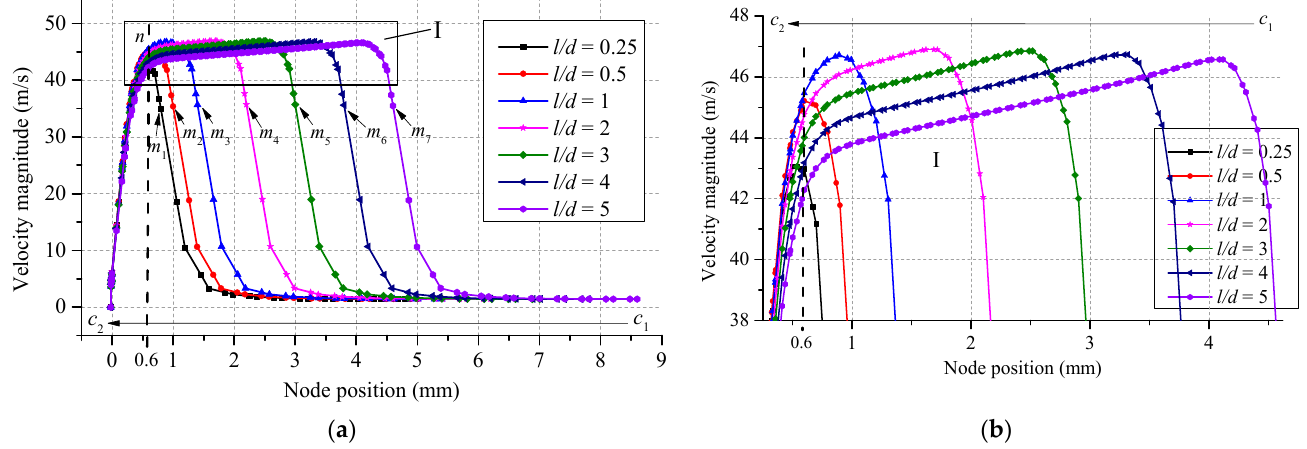
Figure 5. Velocity magnitude patterns of various OLDRs along the line of c 1 – c 2 . ( a ) Velocity magnitudes of various OLDRs along the line of c 1 – c 2 ; ( b ) local enlarged view of Ⅰ .